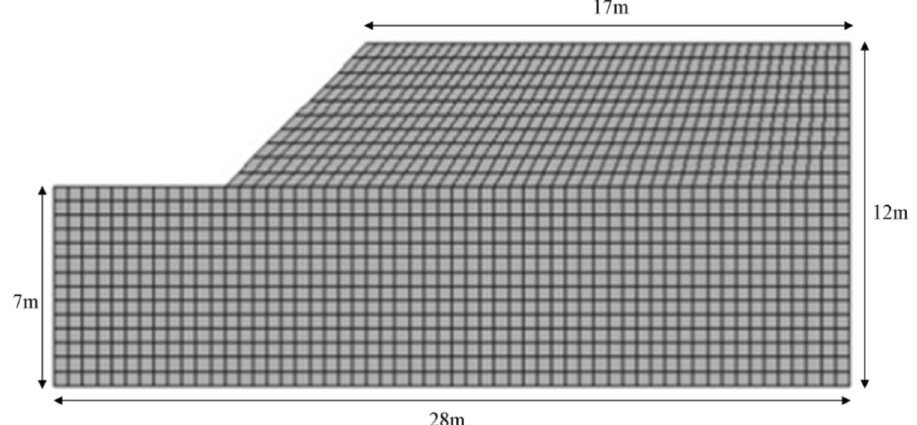
Fig. 2 Slope geometry after the trench excavation